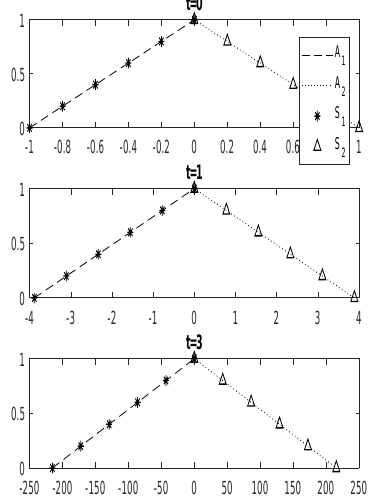
Figure 6. Line graph for differential Equation (6) with